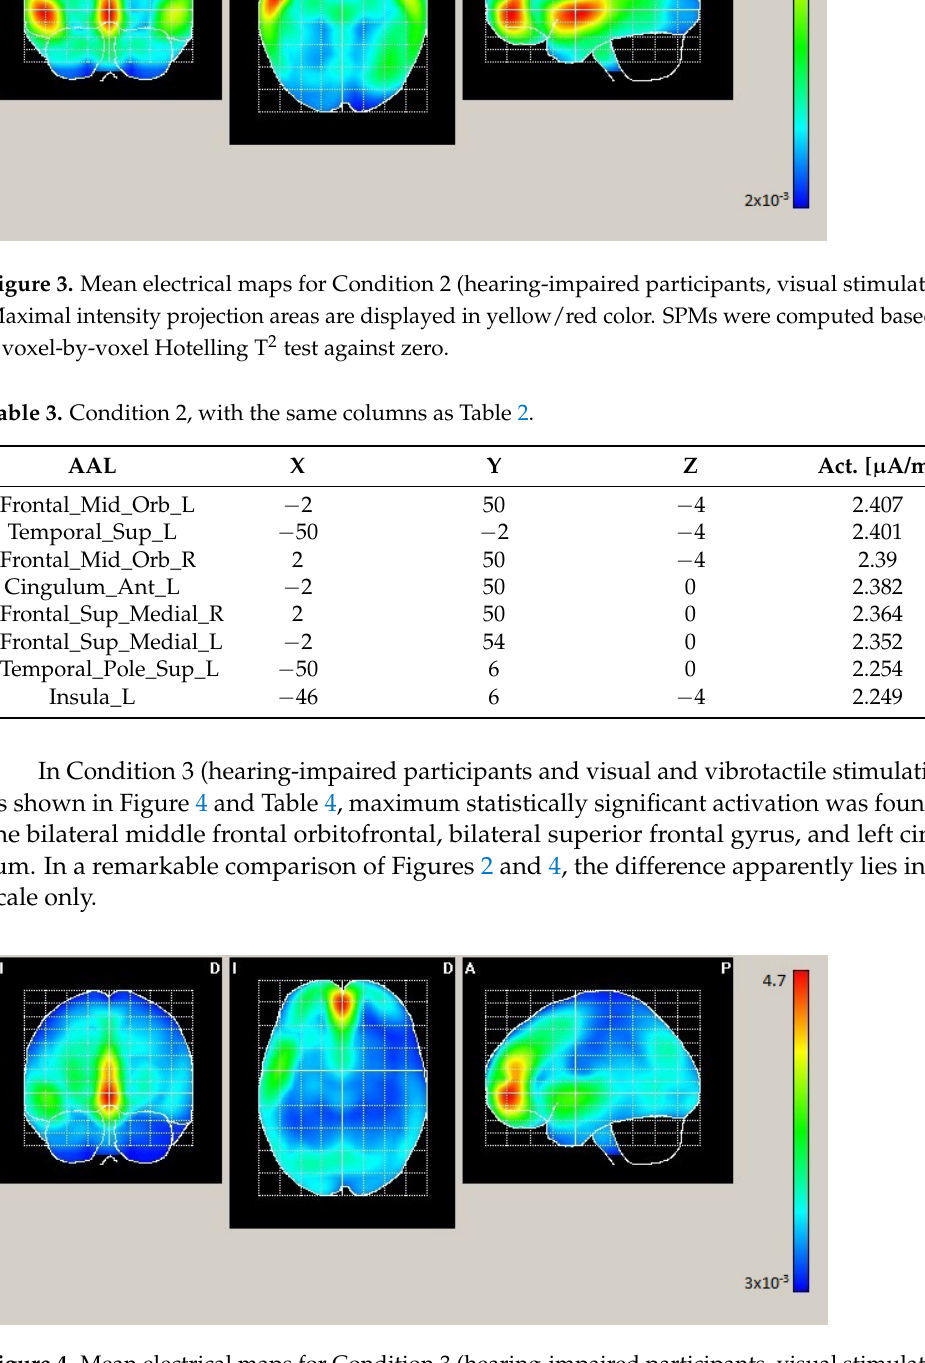
Figure 4. Mean electrical maps for Condition 3 (hearing-impaired participants, visual stimulation). Maximal intensity projection areas are displayed in yellow/red color. SPMs were computed based on a voxel-by-voxel Hotelling T 2 test against zero. Table 4. Condition 3, with the same columns as Tables 2 and 3.